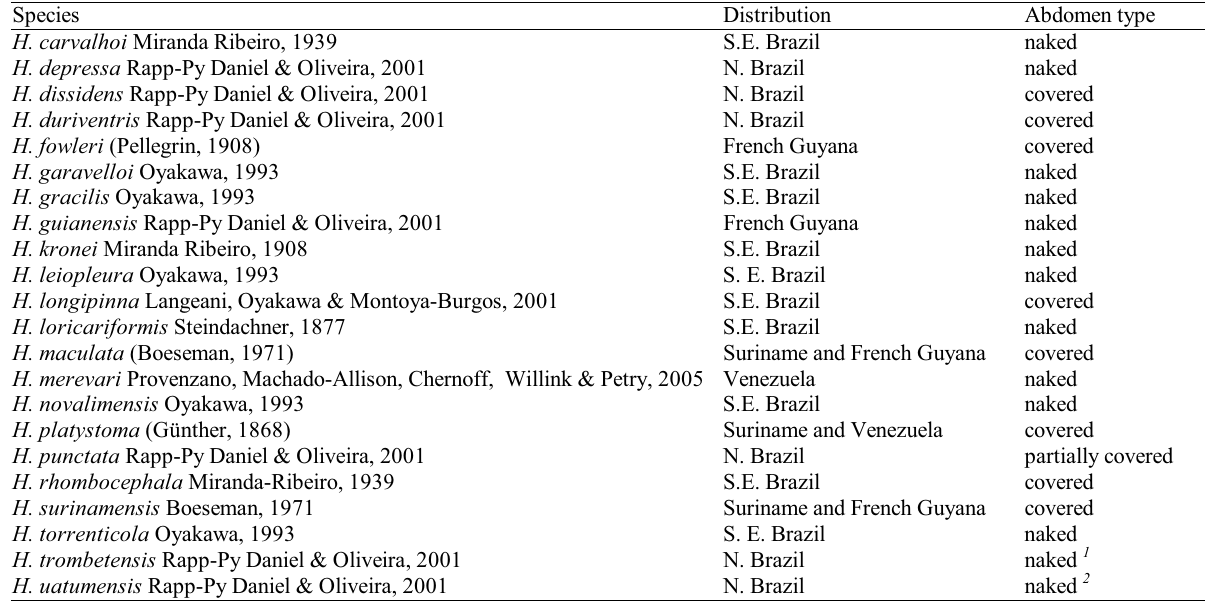
Table 1. List of the species of the genus Harttia , geographic distribution and abdomen type (1 - a stripe of tiny plates before the pelvic fins; 2 - three to five small plates at the scapular girdle level). Species